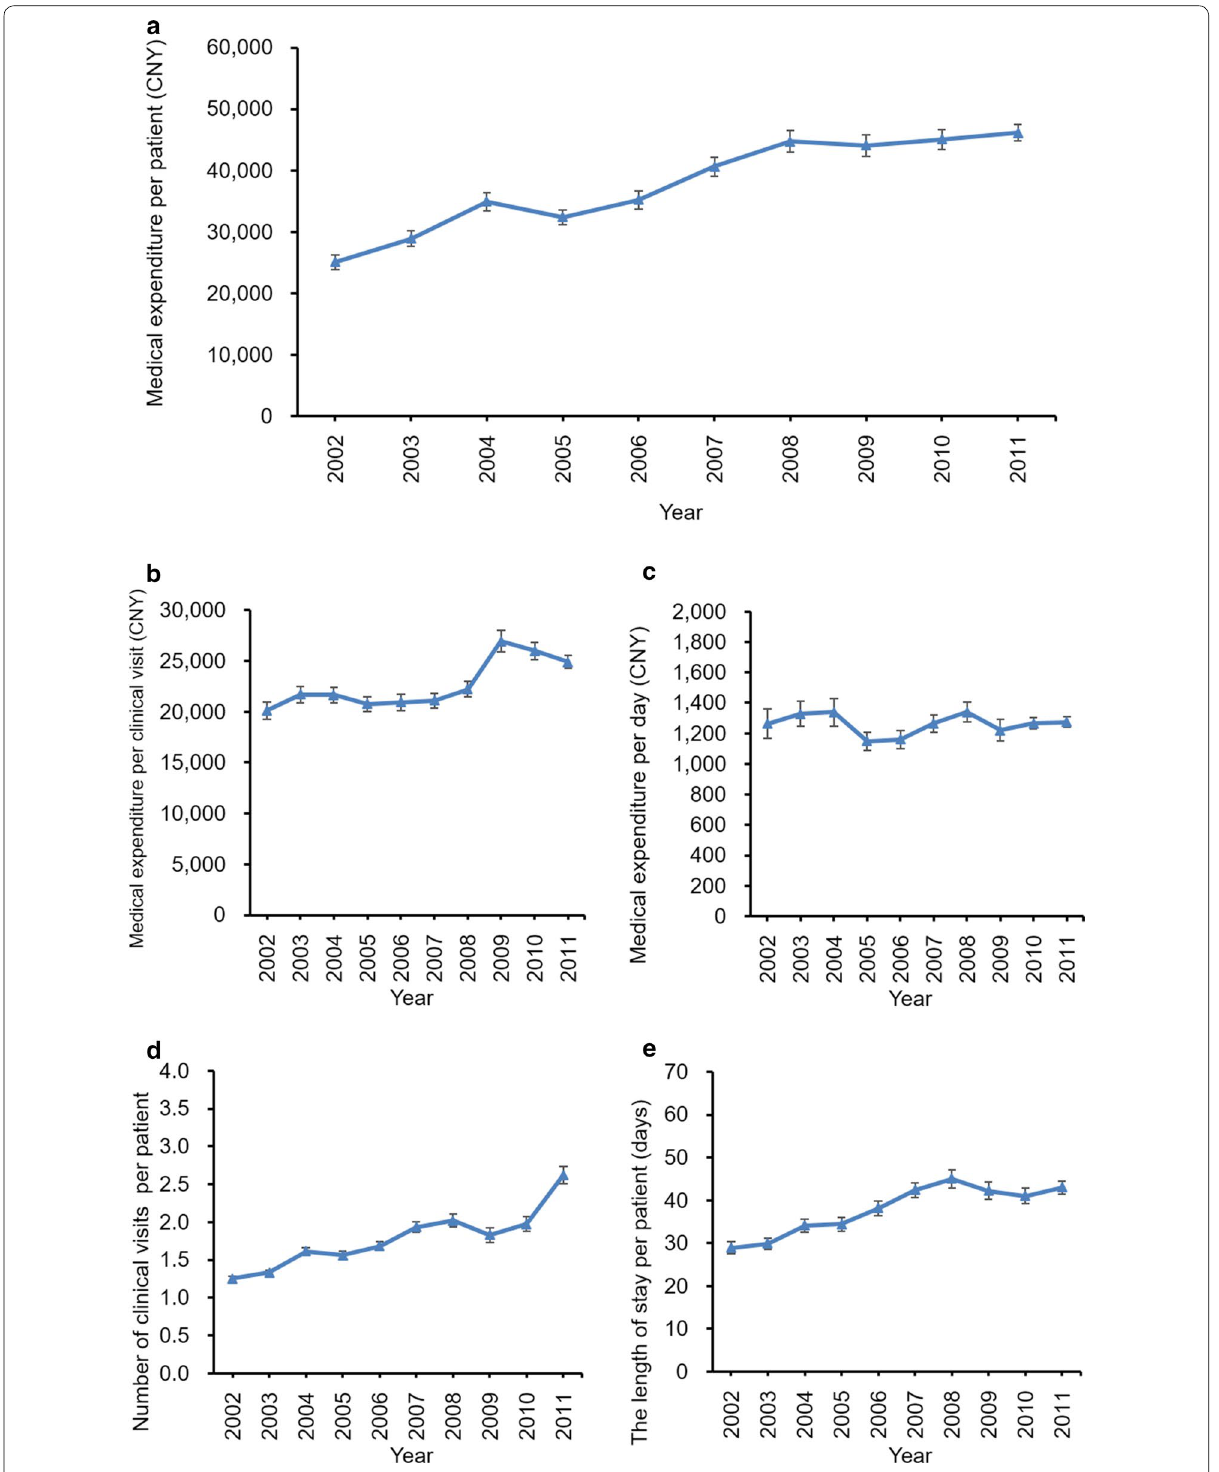
Fig. 2 Time trend of medical expenditures and related factors for esophageal cancer diagnosis and treatment in China, 2002–2011. a Time trend of overall average medical expenditures per patient; b time trend of medical expenditures per clinical visit; c : time trend of daily average medical expenditure; d time trend of number of clinical visits per patient; e time trend of the length of hospitalization stay per